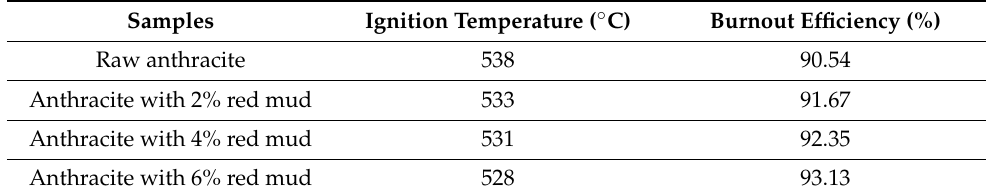
Table 2. Effects of red mud on coal ignition temperature and burnout efficiency.